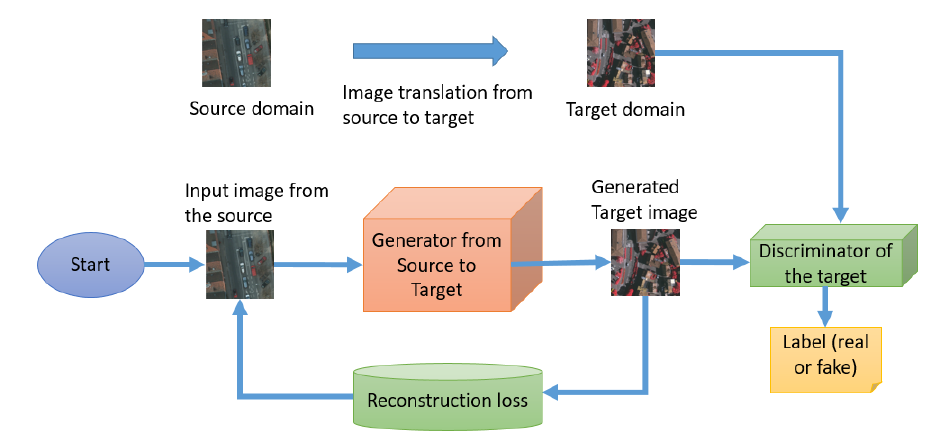
Figure 3. Generative adversarial network (GAN) architecture for unpaired image translation in aerial